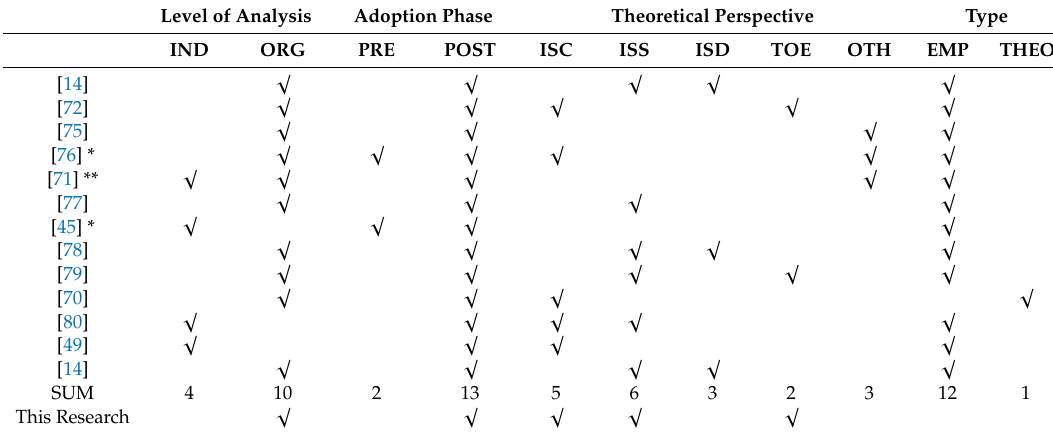
Table 1. Literature on CC Continuance.